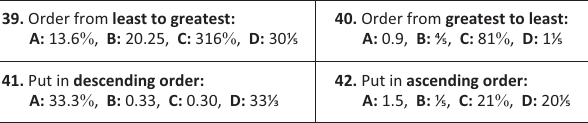
FIGURE 10: Final subtest.